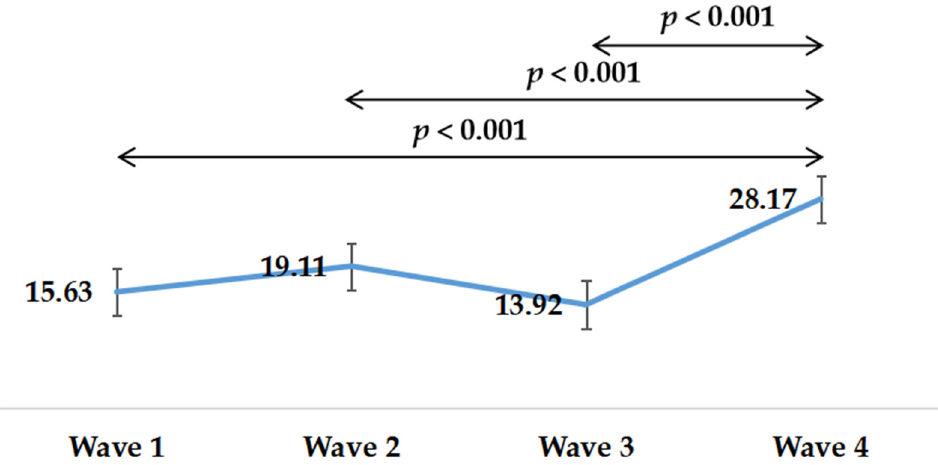
Figure 1. Changes in moderato to vigorous physical activity in four waves during the COVID-19 pandemic. Changes in LPA during the survey period were shown in Figure 2. LPA time presented an upward trend. LPA time of Wave 1 ( p < 0.001) and Wave 2 ( p < 0.001) was significantly less than that of Wave 4.